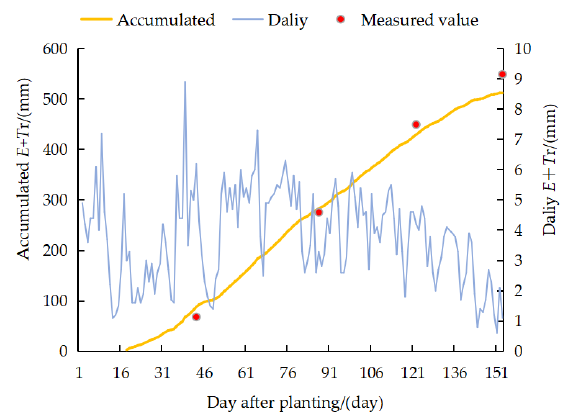
Figure 2. Simulated and measured accumulated ET c ( E + T r ) during the growing season in Harbin, 2014. ET : soil evaporation, T r : crop transpiration, same as below. 2014. ET : soil evaporation, T r : crop transpiration, same as